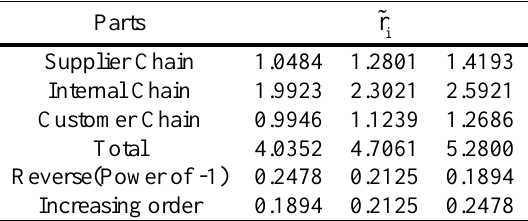
Table 6. Geometric means of fuzzy comparison of each